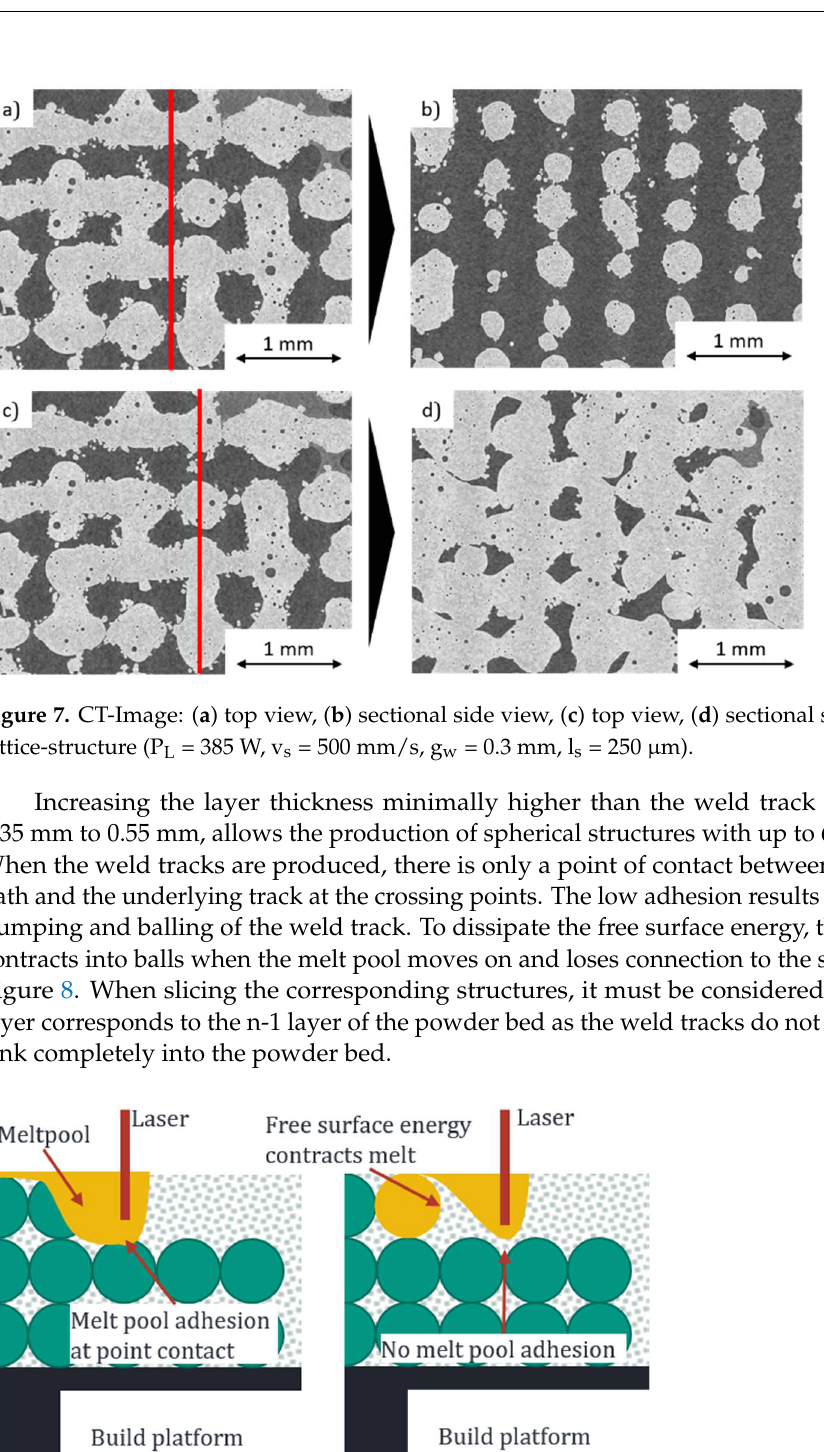
Figure 8. Explanation of the spherical-structure creation process. The CT images of the spherical structures show that the connection between the